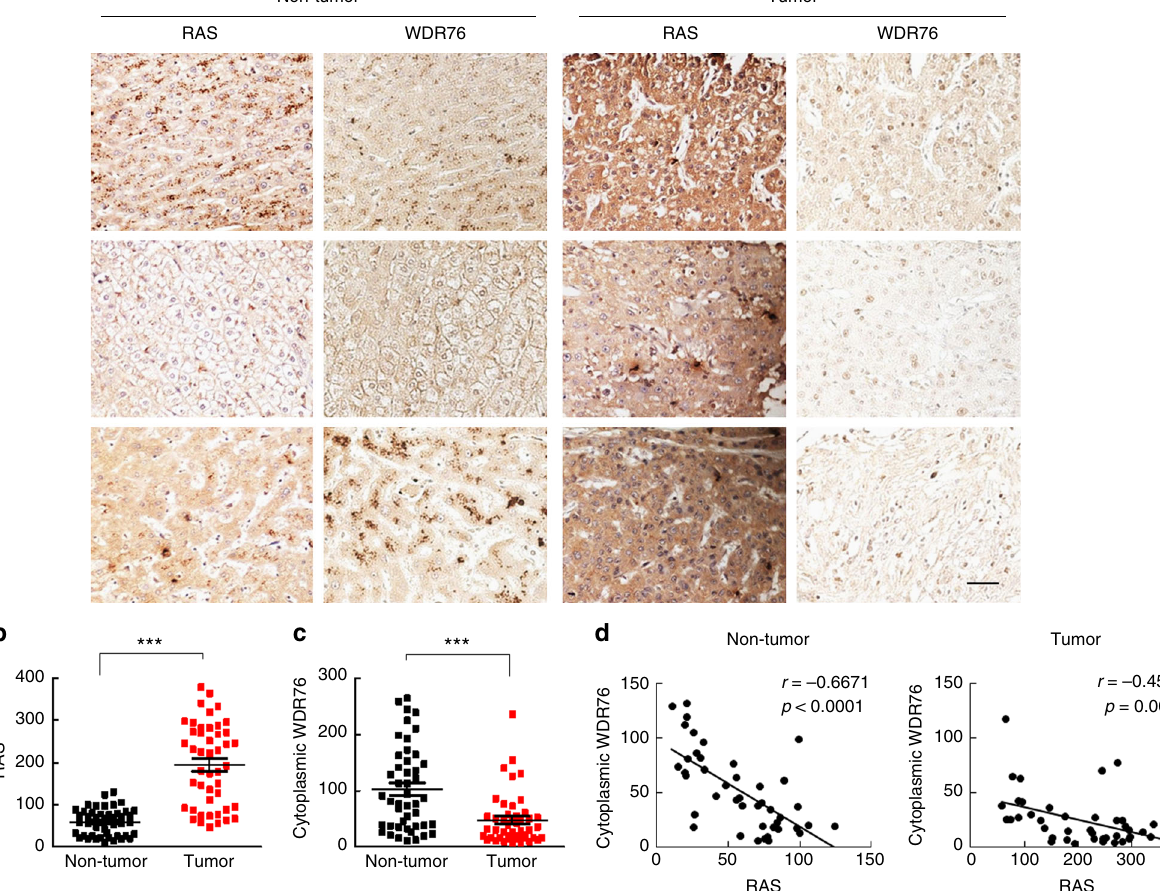
Fig. 6 Expression of RAS and WDR76 proteins in tumor and adjacent non-tumor tissues from human HCC. a Representative DAB staining images of RAS and WDR76 from tumor and paired adjacent non-tumor tissues fi xed on human HCC TMA slides. b , c Quantitative analyses of RAS ( b ) and cytoplasmic WDR76 ( c ) were performed by comparing tumor and adjacent non-tumor tissues based on H-Score. d A graph showing the inverse correlation between RAS and WDR76 expression of 46 sets of human HCC tissues with matched adjacent non-tumor tissues. All values were calculated using Student ’ s t test or Pearson correlation analyses. *** p < 0.001. Scale bars, 100 µ